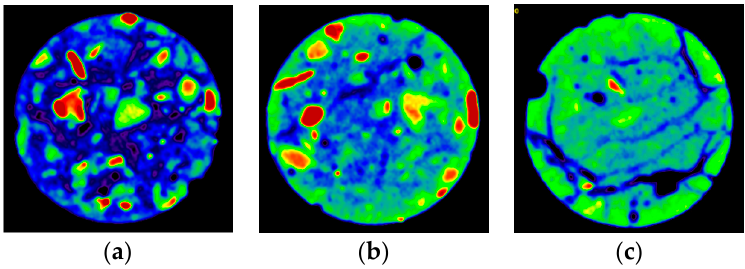
Figure 12. CT images after the rupture of the mixed disposal body at different waste rock concentrations. ( a ) Waste rock of 50%; ( b ) waste rock of 30%; and ( c ) waste rock of 10%.